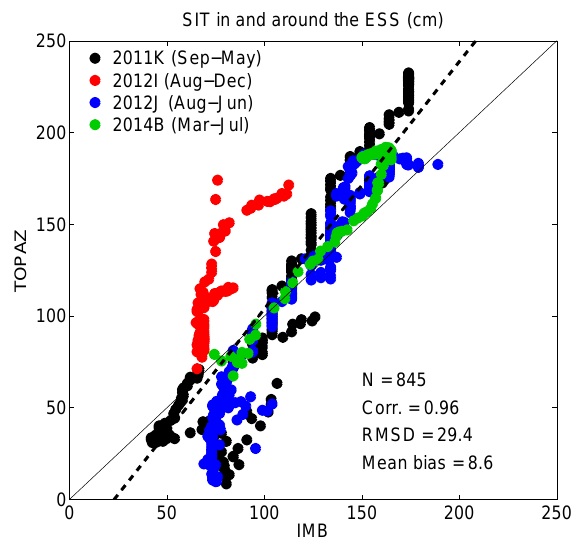
Figure 4. The comparisons of the daily mean SITs derived from IMB buoy data with the corresponding SIT in TOPAZ4 reanalysis data from 2011 to 2014 in and around the ESS. The SIT data are resampled every 7 days. The regression lines for the IMB buoy data and the reference unit line are shown by solid and dashed